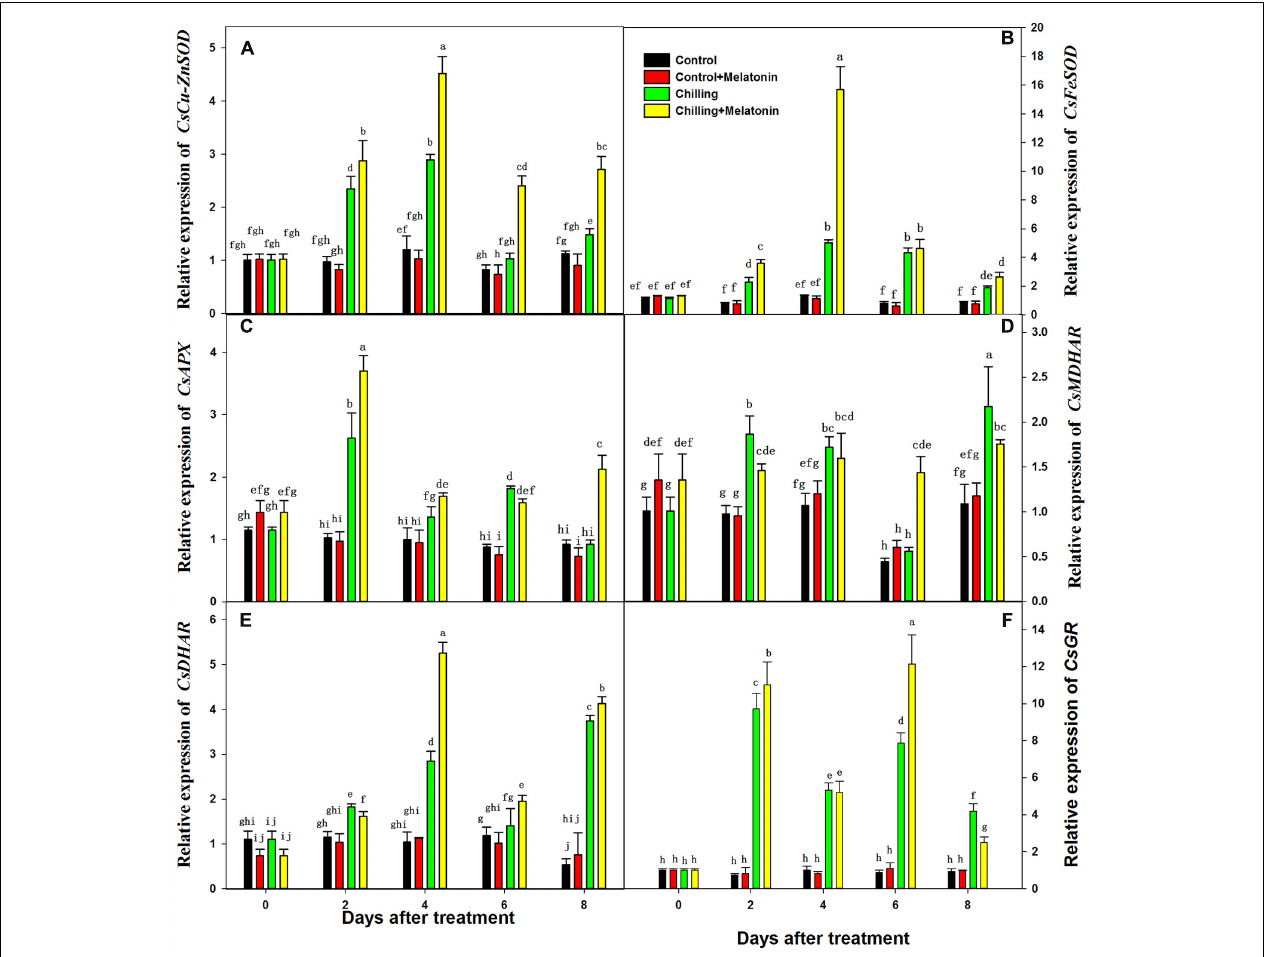
FIGURE 8 | Effects of exogenous melatonin on transcript levels of key genes involved in biosynthesis of enzymes of ASA-GSH cycle under chilling stress. (A) CsCu-ZnSOD , (B) CsFeSOD, (C) CsAPX , (D) CsMDHAR, (E) CsDHAR , (F) CsGR. Control (28/18 ◦ C); Control + Melatonin (200 µ M melatonin, 28/18 ◦ C); Chilling (15/8 ◦ C); Chilling + Melatonin (200 µ M melatonin, 15/8 ◦ C). Data are means ± SD of three